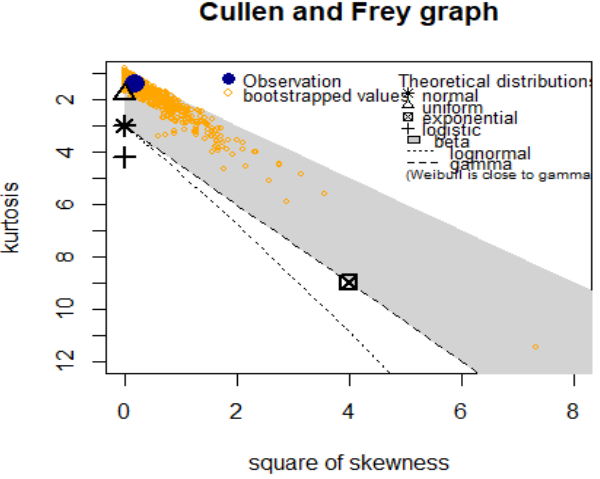
Figure 6. Estimated marginal distribution for HIV/AIDS for males.